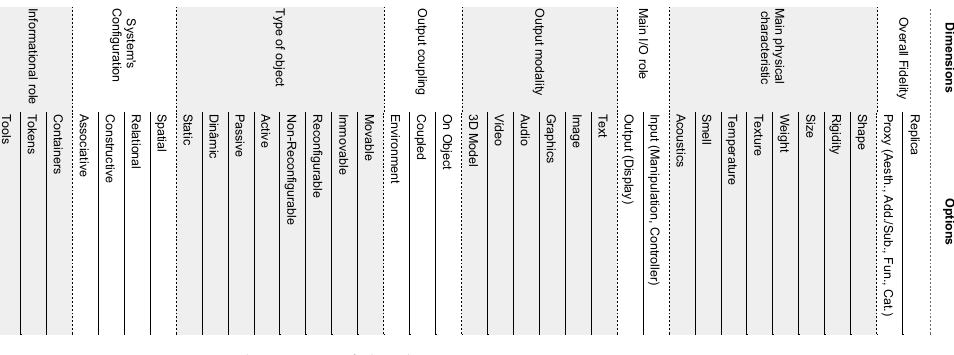
Figure 2. Dimensions and options of the design